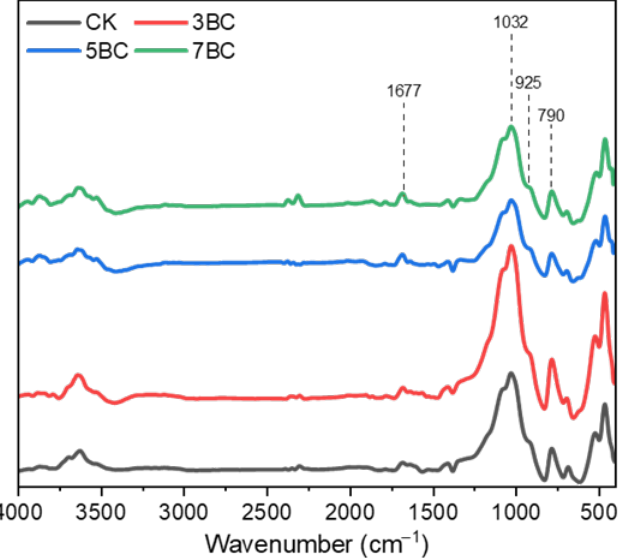
Figure 2. Infrared spectra of soil after 60 d of incubation. CK, no biochar amendment; 3BC, 300 °C straw biochar amendment; 5BC, 500 °C straw biochar amendment; 7BC, 700 °C straw biochar